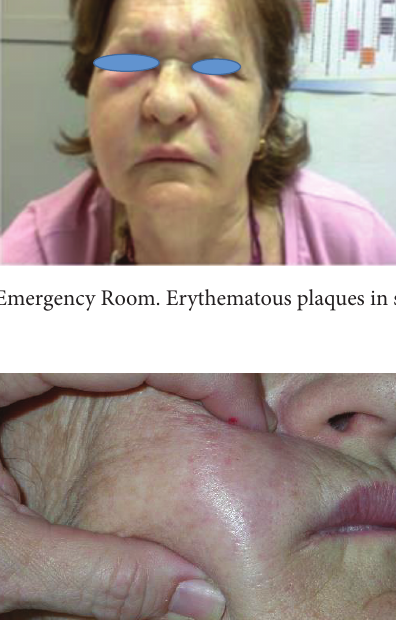
When trying to lower the dose of corticoid, the patient suffers a new episode of edema and as a consequence the dose of oral corticoid is raised and is associated with a corticoid topic